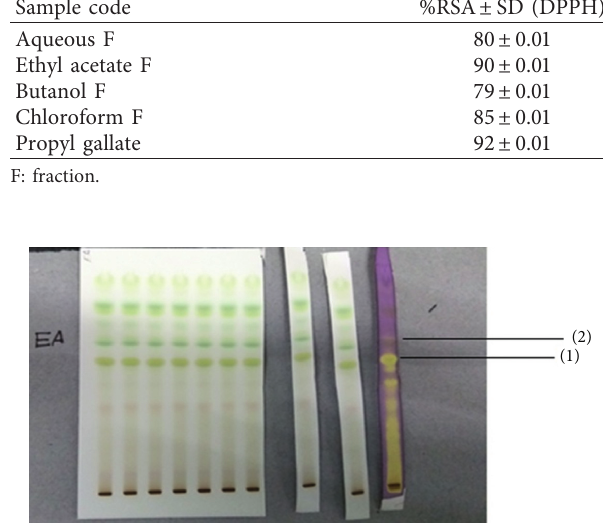
Figure 1: Bioautographic assay showing the inhibition of α -amylase by some compounds developed on a silica gel G60 F254 plate which was eluted with toluene : ethyl acetate : formic acid (5 : 4 :1, v/v/v) as the mobile phase.